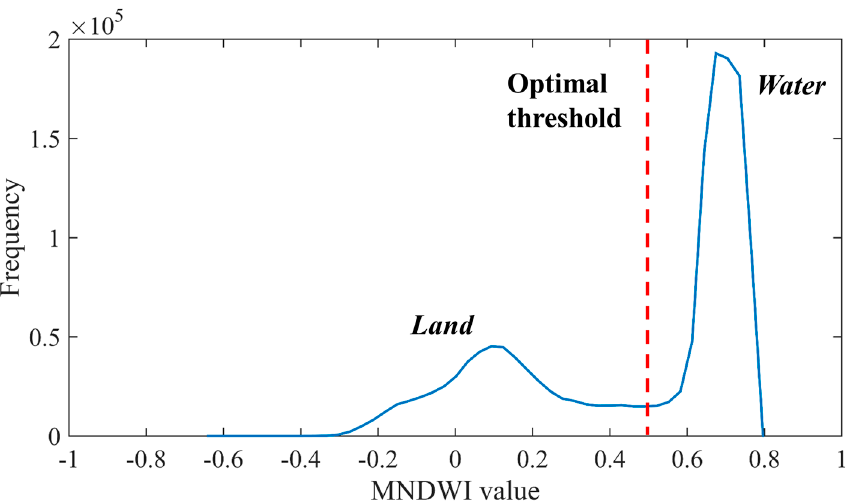
Figure 3. An example of determining an optimal threshold from the frequency distribution of an annual MNDWI map of the estuarine islands in 1990. Note that the frequency distribution has been smoothed with a 5-point moving average filter. The threshold corresponds to the valley of the MNDWI frequency distribution was determined as the optimal threshold.